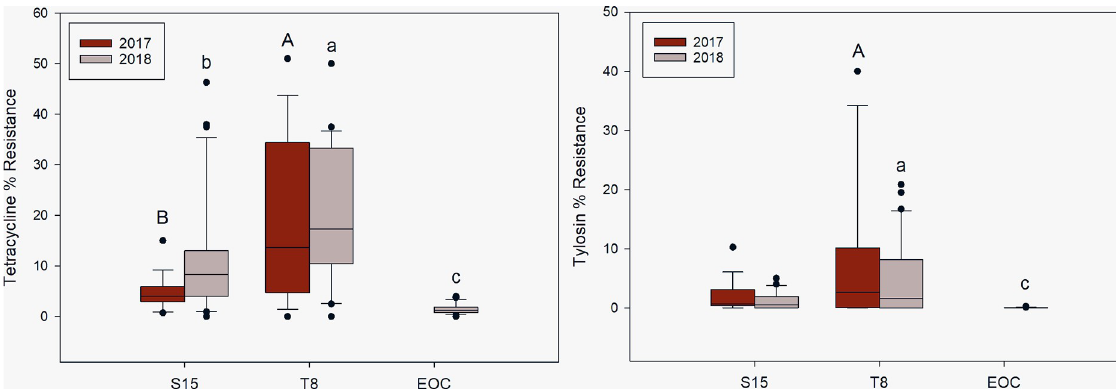
Fig 4. Box-plots of tetracycline and tylosin percent resistant enterococci for the mixed land use comparison. The middle line on the box- plot represents the median while the upper quartile of the box represents the 75 th -percentile and the lower quartile the 25 th -percentile. The whiskers denote the range of the quartiles and outliers are marked as dots. The letters above each plot represent significant differences based on the Wilcoxon Rank-Sum Test. Capital letters are associated with 2017 and lower-case letters are associated with 2018. Differing letters mean significant difference between